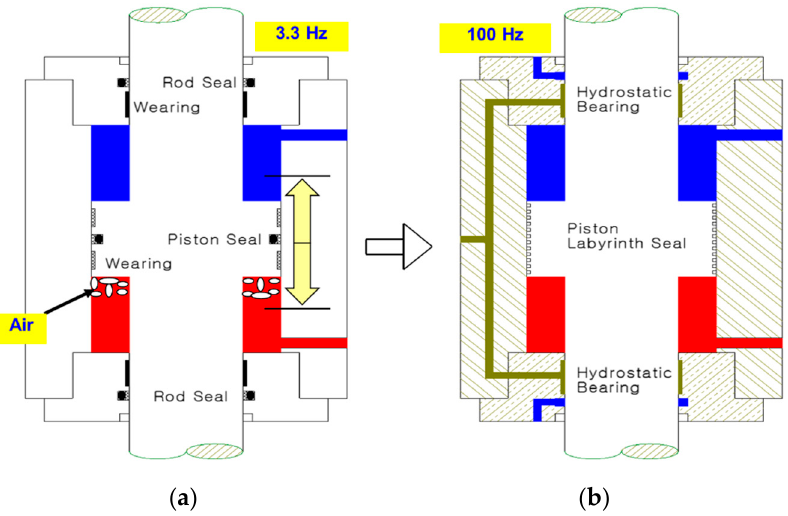
Figure 4. Comparison of elastic seal type and labyrinth seal type. ( a ) Low friction seal; ( b ) Labyrinth seal.